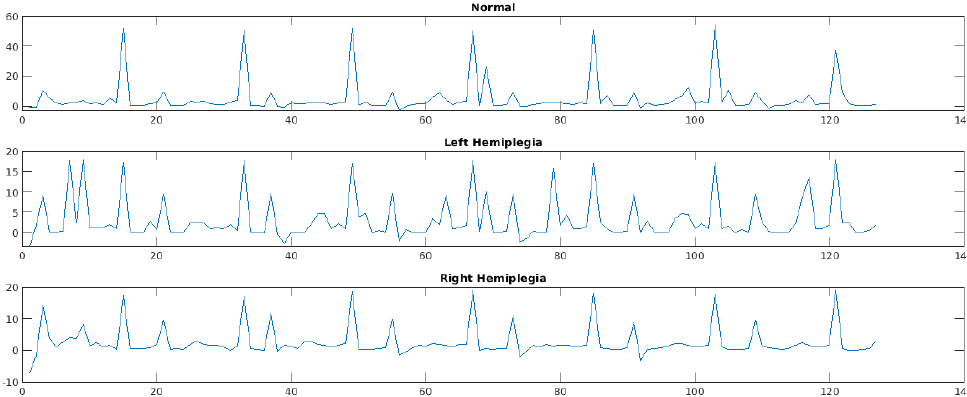
Figure 3. A visualization of three input patterns. The current figure depicts three input patterns after the pre-processing and feature extraction stages are applied to the accelerometer’s signals dataset corresponding to three signal types (normal, left, and right